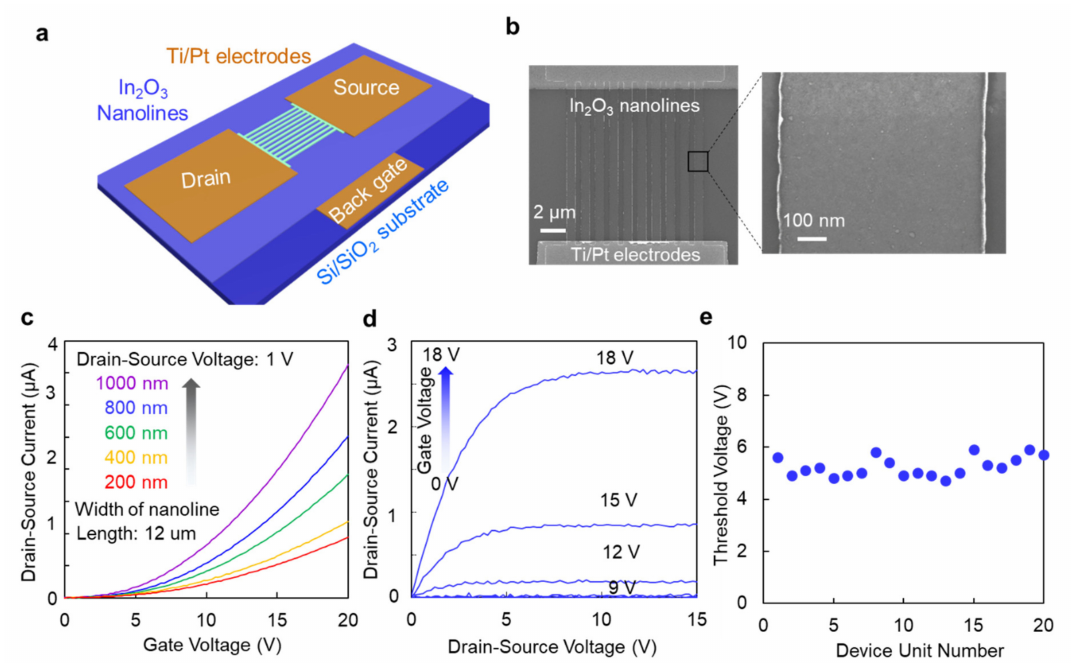
Figure 2. The In 2 O 3 nanolines FET device. ( a ) Schematic drawing showing the FET device. ( b ) FESEM images of the In 2 O 3 nanoline area. ( c ) Transfer curve. The FET devices when varying the width of single line were measured. The drain-source voltage was 1 V. ( d ) Output curves. The back-gate voltages were increased from 0 V to 18 V. ( e ) Measured threshold voltages for 20 units of the In 2 O 3 FET sensing device. The width of device is 800 nm.